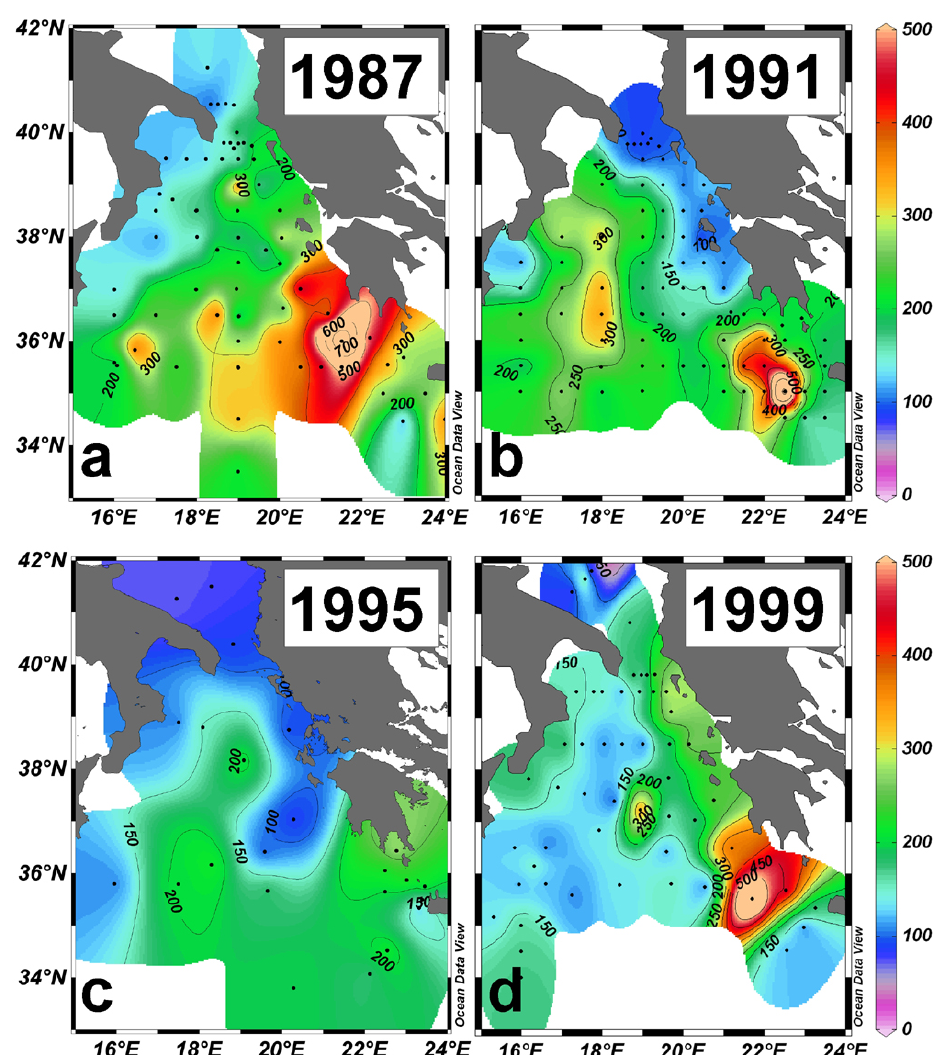
Fig. 3. Nutricline (depth of [nitrate] = 3µM) horizontal distributions in the Ionian Sea in (a) 1987, (b) 1991, (c) 1995 and (d) 1999. Depth in